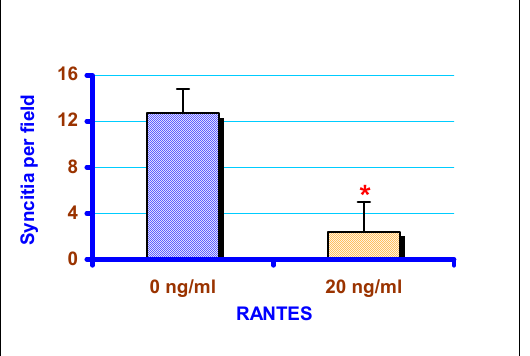
Figure 7. Exogenous RANTES inhibits CAEV replication in GSMC in vitro . 20 ng/ml exogenous RANTES was added 3 h prior to infection with 1 X 10 6 TCID /ml CAEV, and at 24 h and 48 h post- 50 infection. rHu RANTES reduced syncytia formation by 65%. After 72 h, supernatants were harvested for the determination of RT activity. *indicates significant difference from control (P ≤